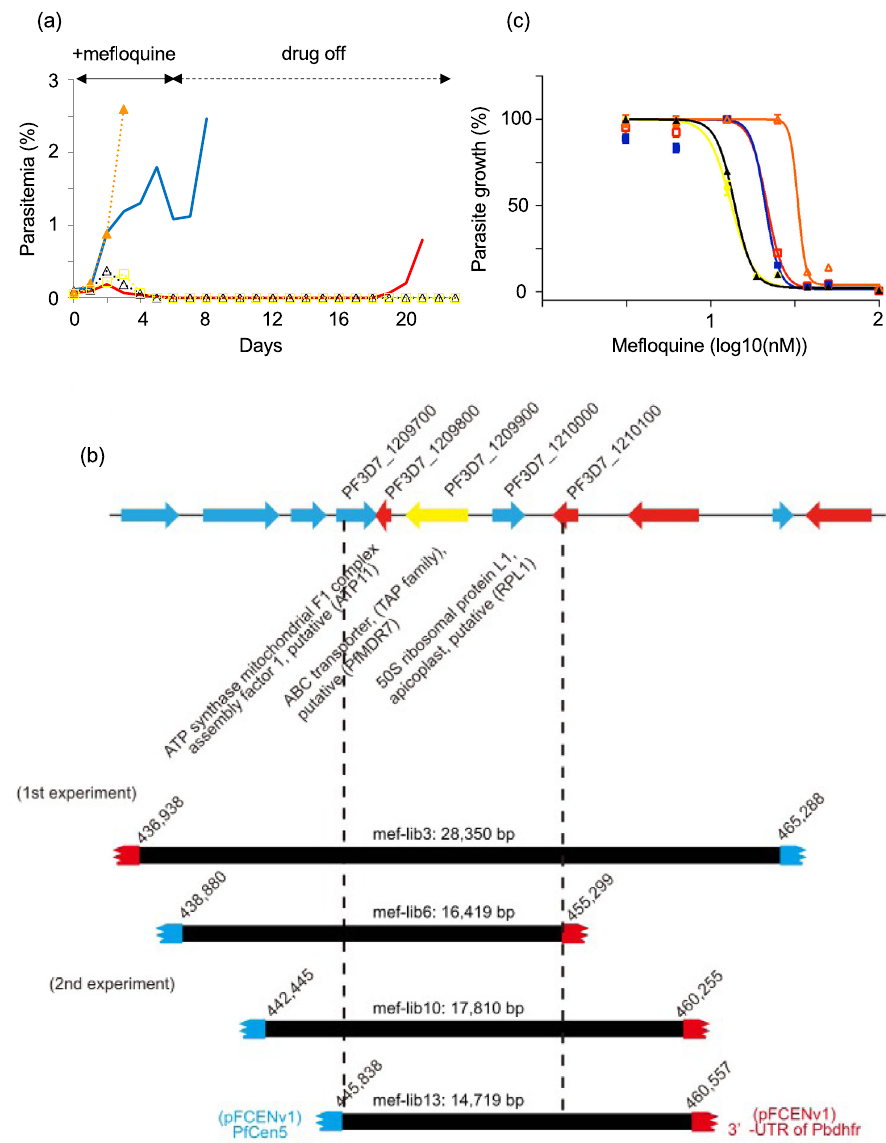
Fig.3|Functionalscreeningofame fl